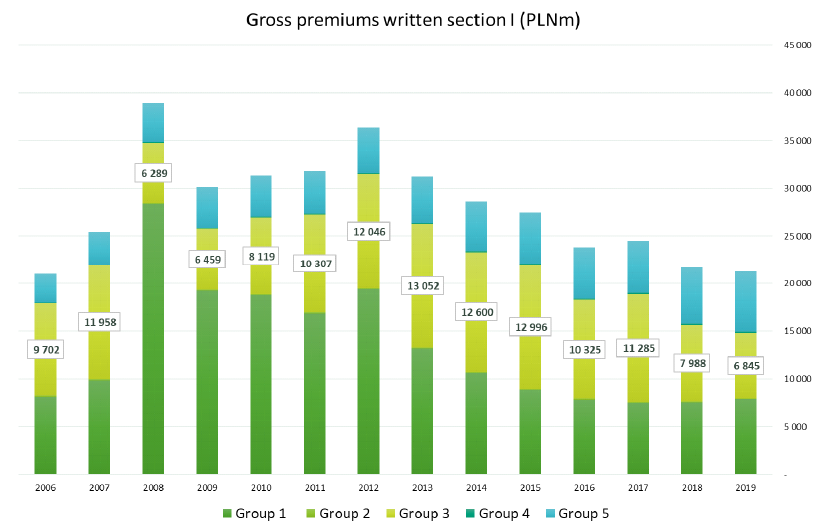
Figure A2. Gross premiums written in Section I, source: own study based on KNF’s data: (Polish Financial Supervision Authority 2001–2019).